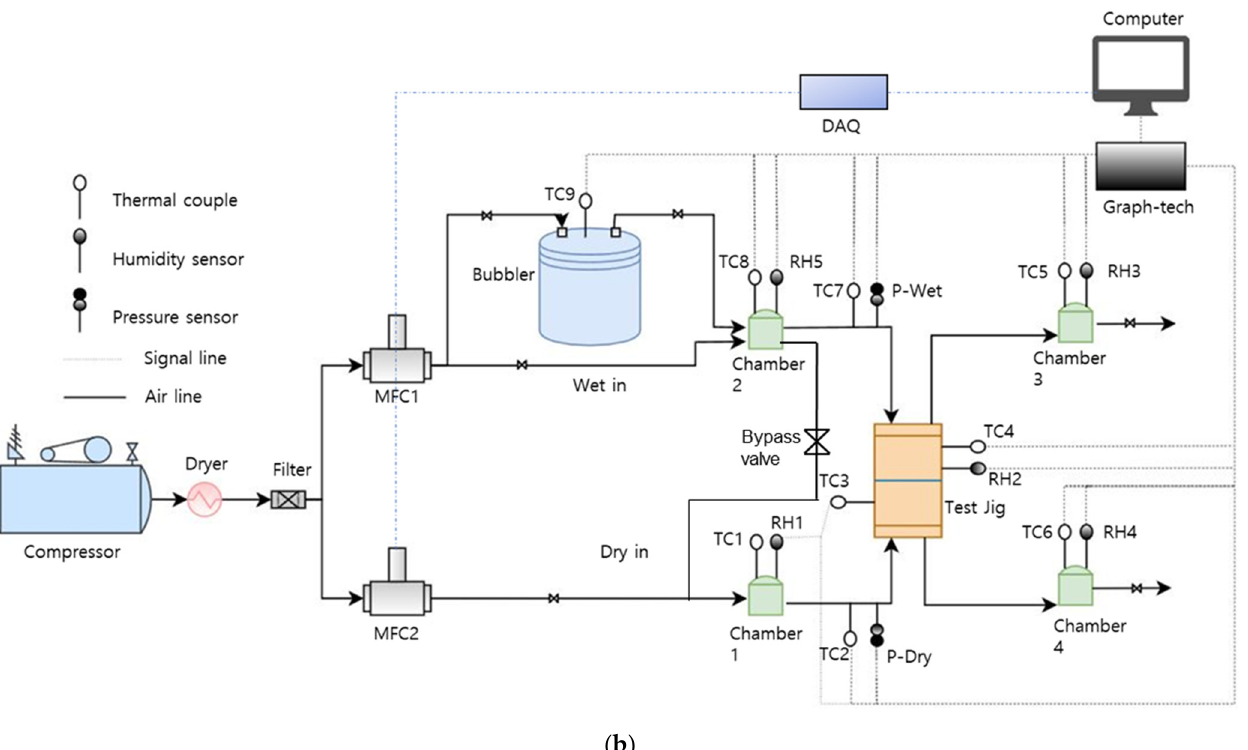
Figure 2. ( a ) Experimental apparatus and ( b ) schematic diagram.